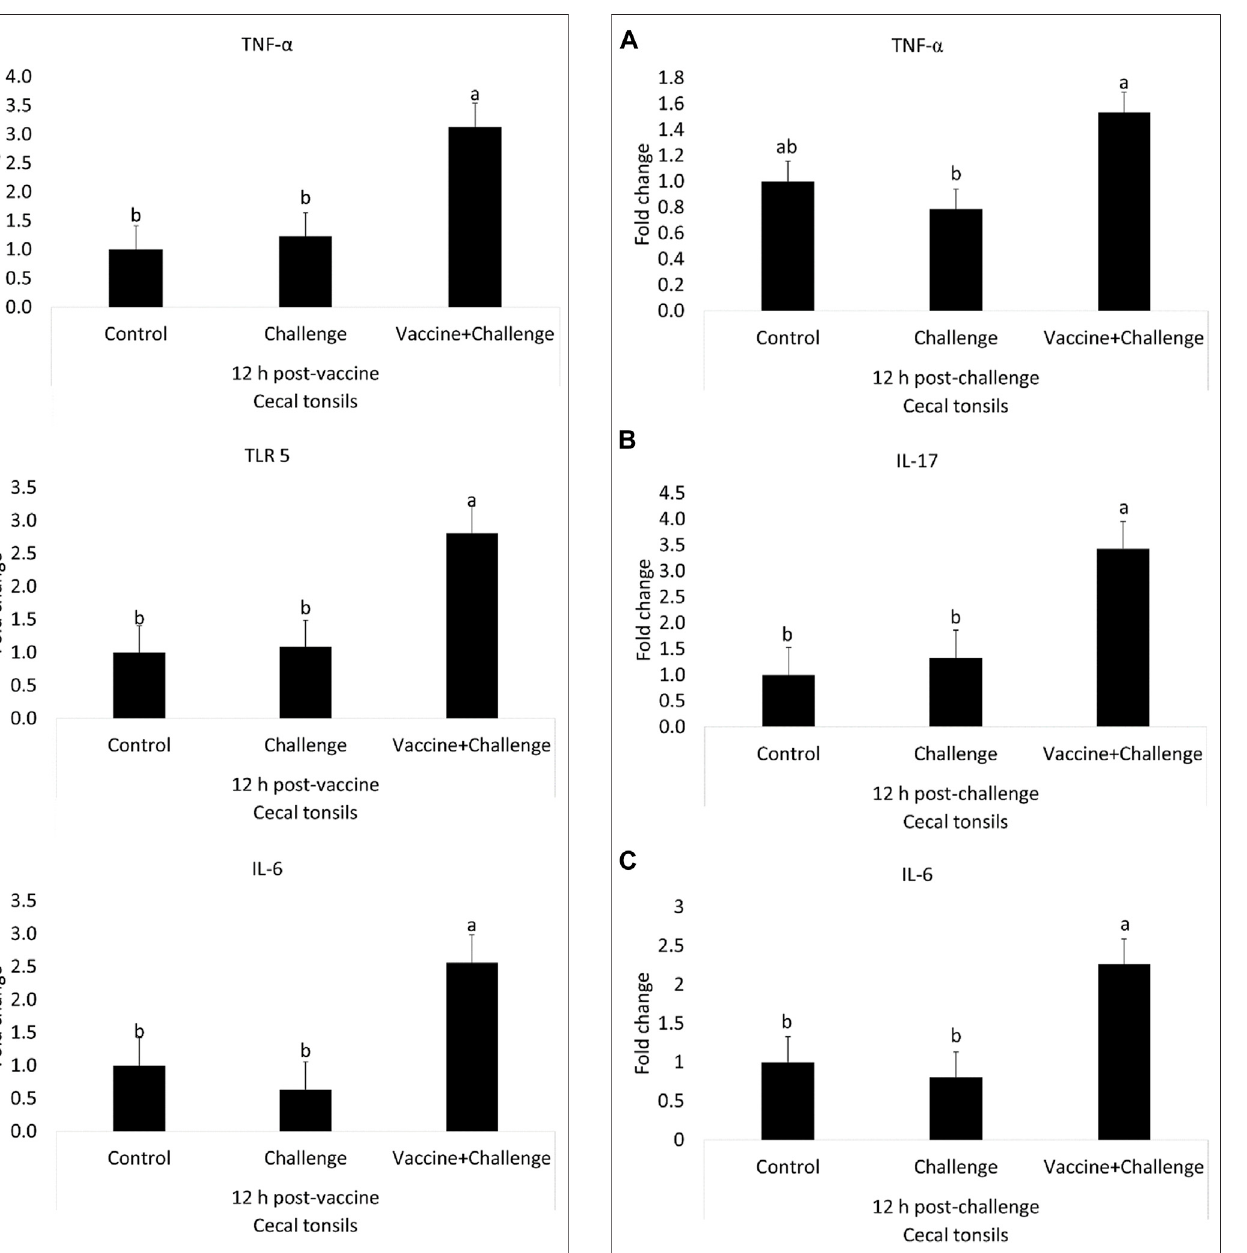
Frontiers in Physiology |